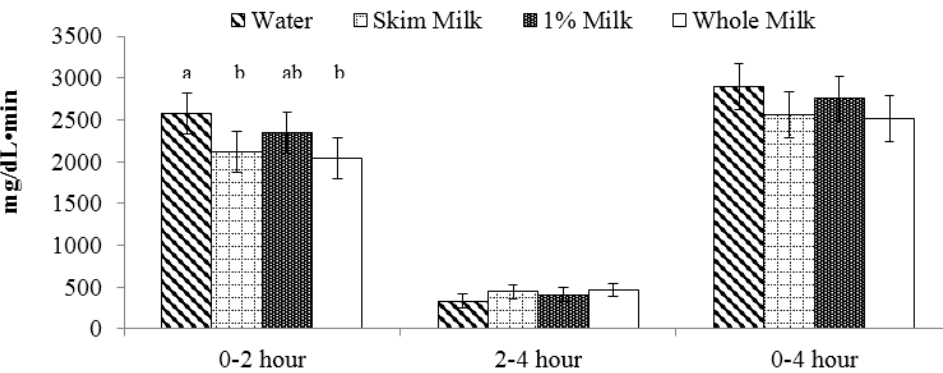
Figure 4. Postprandial plasma glucose responses to breakfast meals consumed with test beverages. ( A ) Changes in glucose concentrations during meal glucose tolerance tests; ( B ) Glucose incremental area under the curve. a,b Bars with different letters (during the same time frame) were significantly different, p < 0.05.